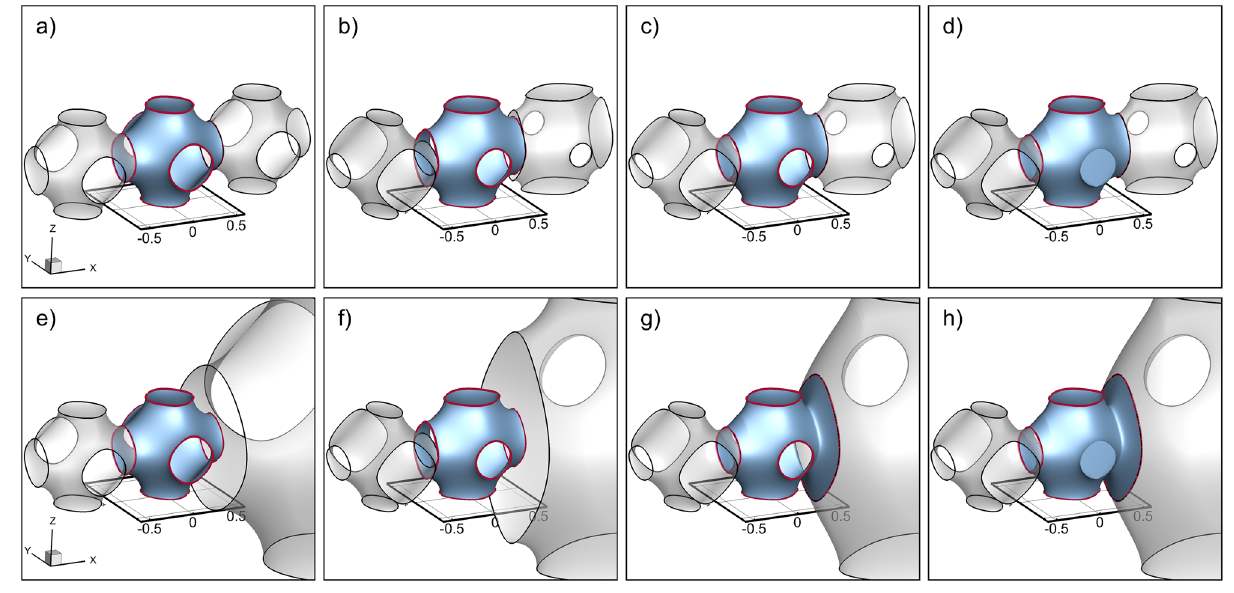
Figure 7. Stepwise creation and manipulation of a single SWP element. Two scenarios are depicted: ( a – d ) show SWP element with a same-sized neighboring unit cell and ( e – h ) show SWP element with a different sized neighboring unit cell. For both scenarios, the following steps are depicted: ( a , e ) initial creation of undeformed SWP element ( b , f ) distortion of the SWP element ( c , g ) gradual fitting of the connecting interfaces of each SWP element to match neighbor coefficients (if necessary, expand to match larger neighbors) ( d , h ) filling interface hole, if no neighbor